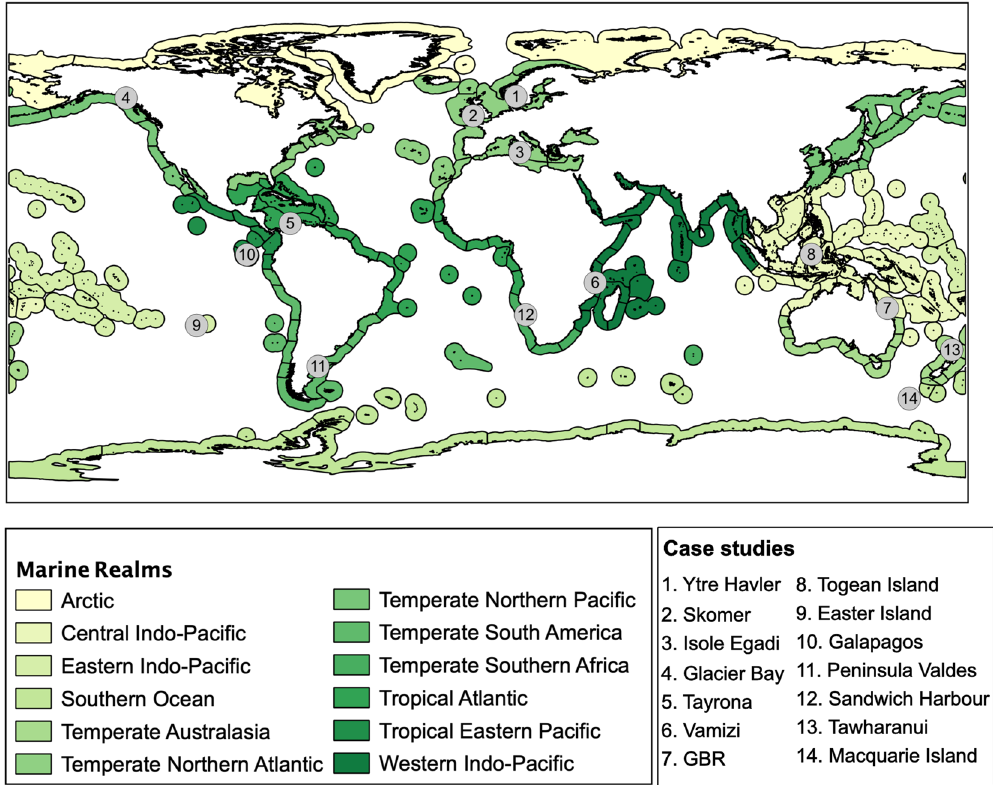
Figure 1. The 14 case studies selected across the twelve marine realms proposed by Spalding et al. 32